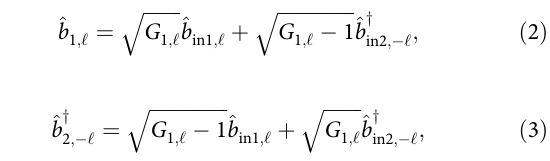
, input state for one OAM-multiplexed channel; ^ a in ;‘